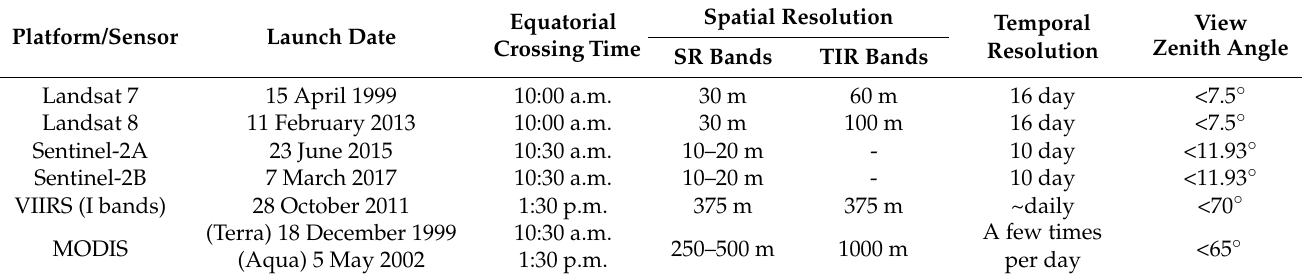
Table 1. Characteristics of satellite sensors used in this